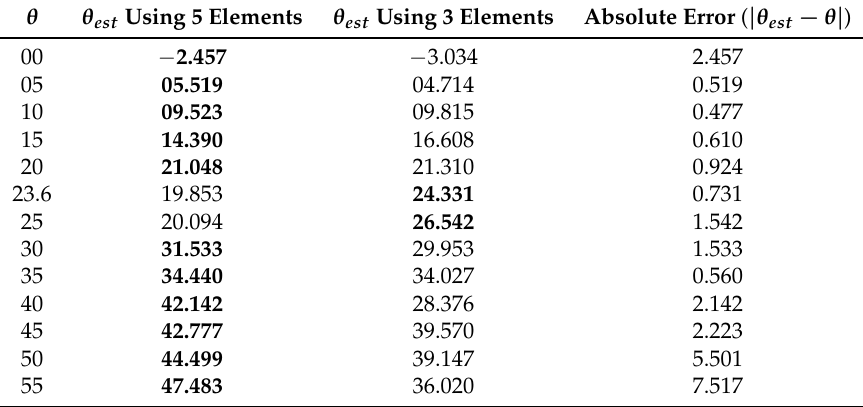
Figure 9. The received harmonic content of an experimental five-element linear microphone array compared to the expected numerical results. Table 1. The estimation results obtained from the system attempting to locate a source at various Direction of Arrivals (DoAs). The estimates marked in bold are the estimates chosen by the system as its